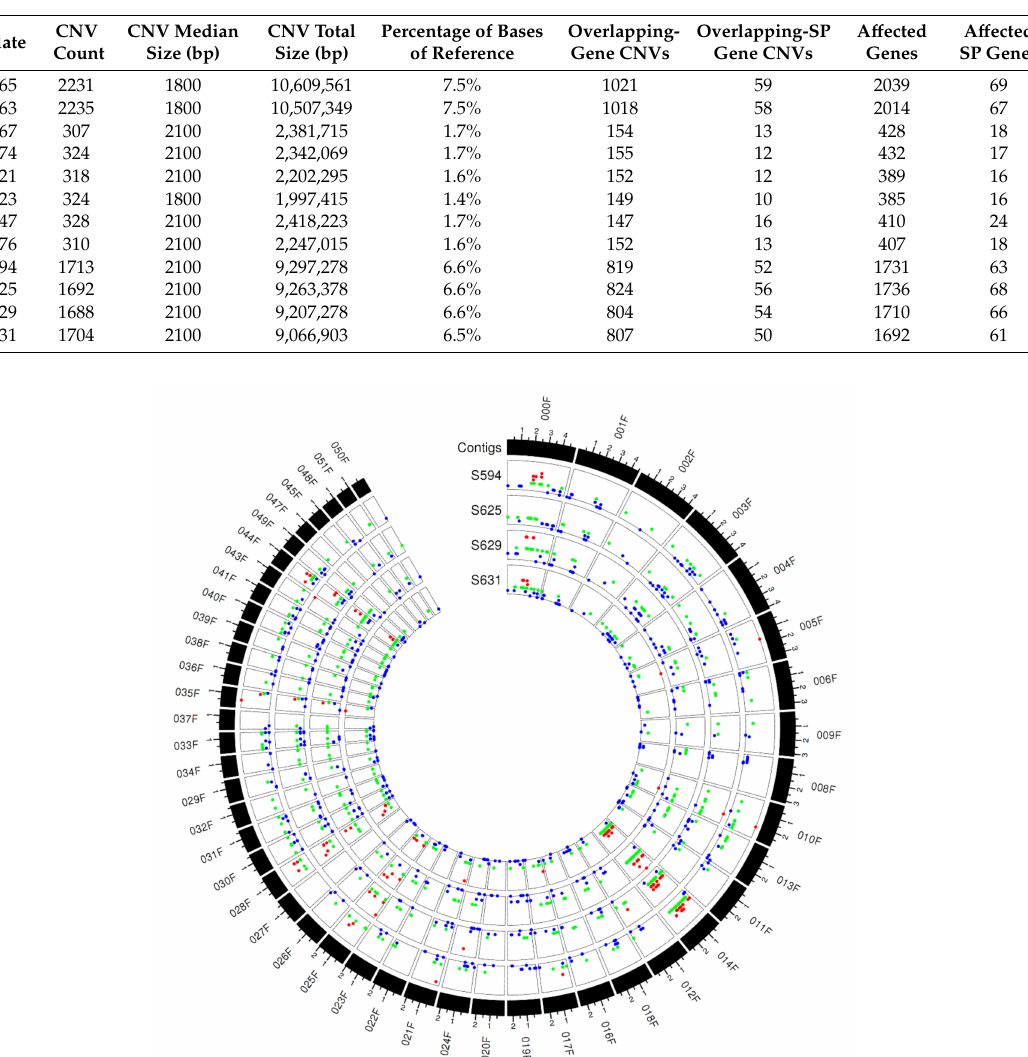
Table 4. Summary of copy number variations (CNVs) in the 12 Pt isolates.